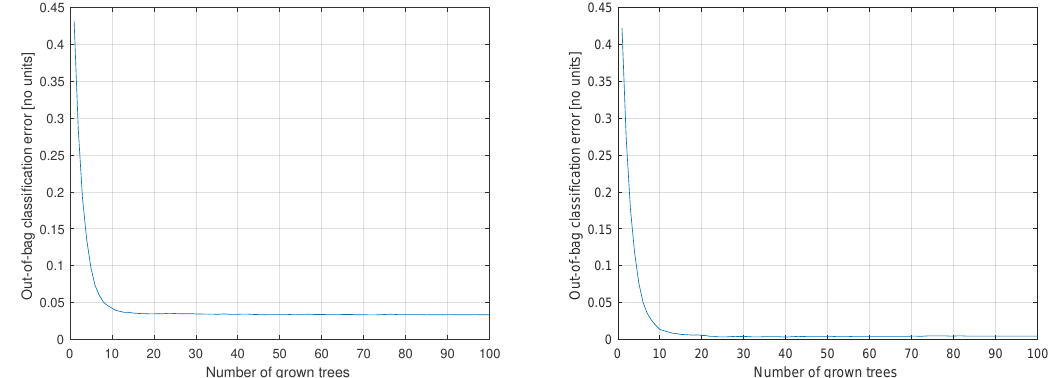
Figure 3. The effect of decreasing the number of trees on the accuracy of the Stage 1 classifier ( left ) and Sedentary classifier ( right ). 10 trees is a reasonable compromise between accuracy and feasibility for on-board implementation.